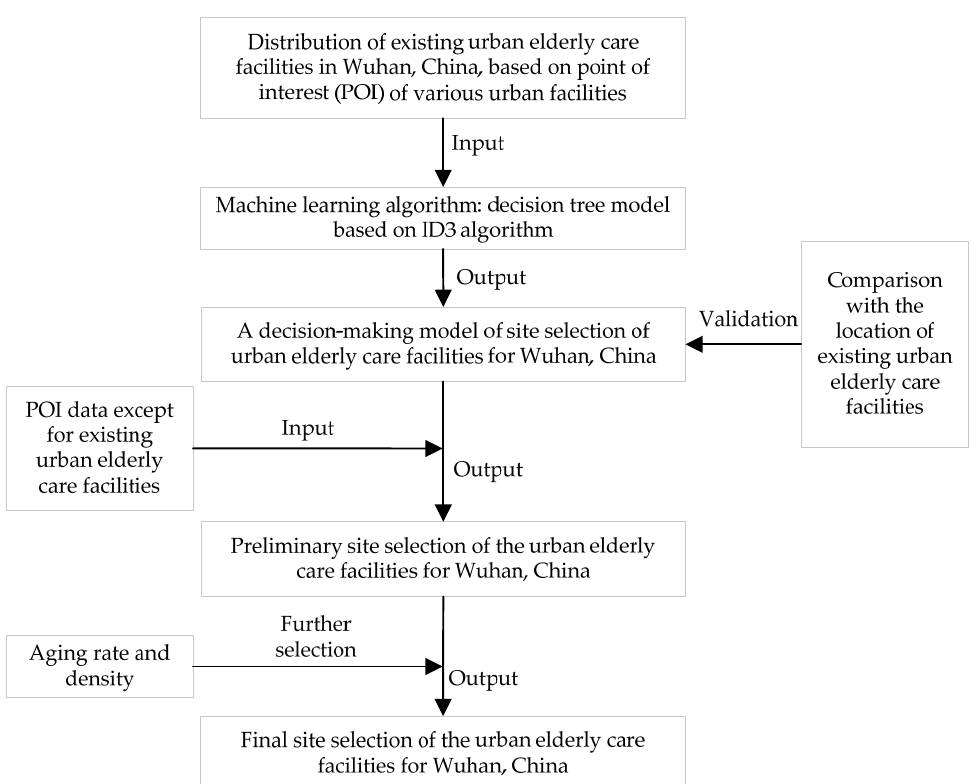
Figure 2. The machine learning method framework for site simulation of urban elderly care facilities.